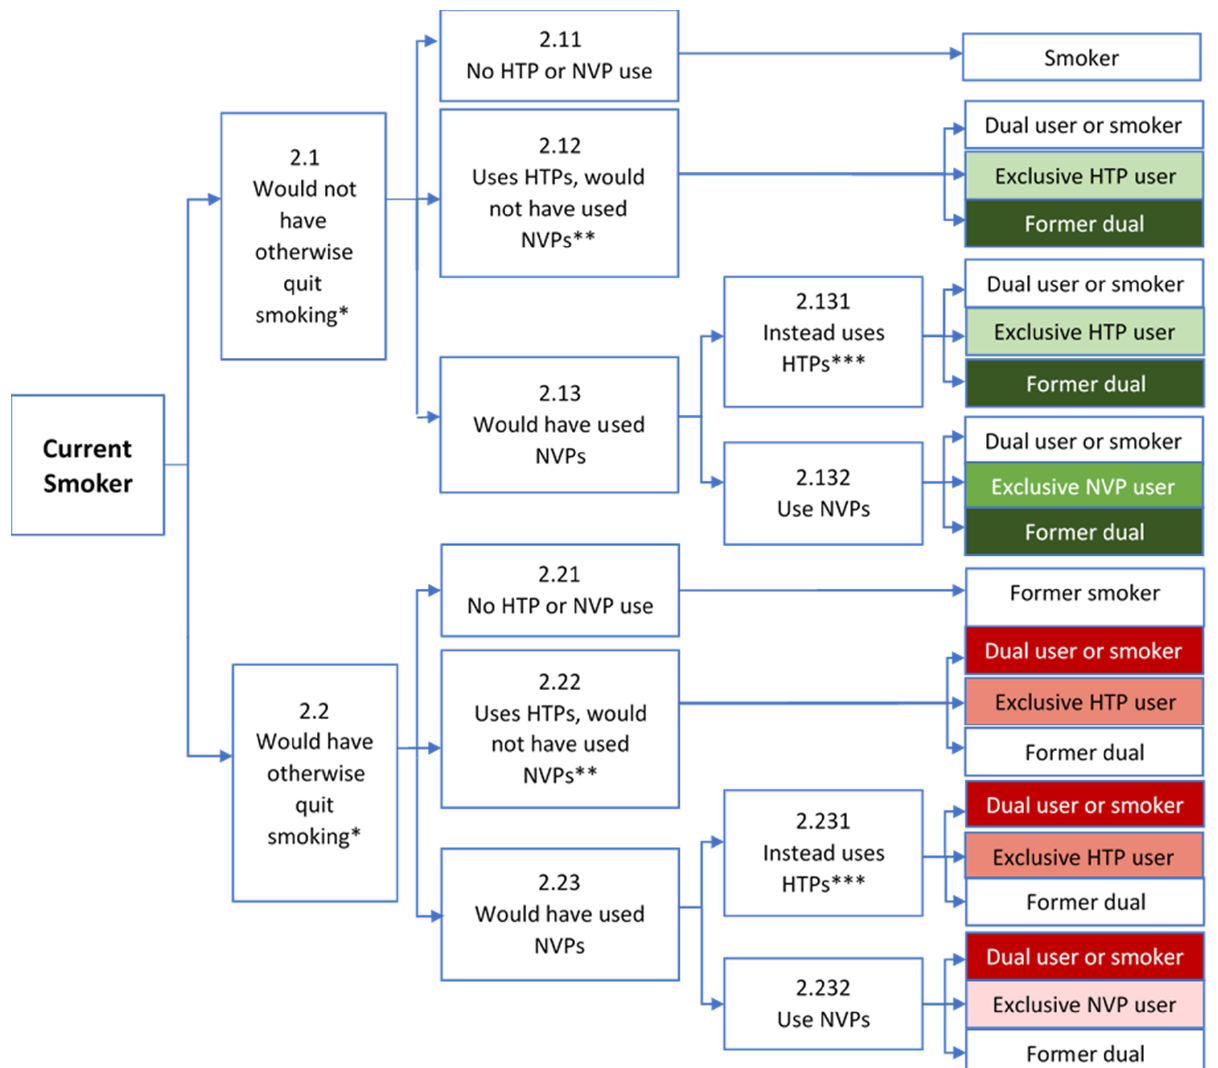
Figure 2. Public Health Impact of NVP and HTP Use Among Current Smokers. Notes: HTP = Heated Tobacco Product, NVP = Nicotine Vaping Product. * Based on the counterfactual of whether smoking cessation would have occurred in the absence of both HTPs and NVPs. ** HTPs are a more desirable alternative to NVPs, e.g., tried NVPs and not found desirable or satisfactory. *** Would have otherwise preferred NVPs, but diverted from use due to industry behavior or govern- ment policy. Green indicates public health benefit; Red indicates public health loss. Darker shades indicate a greater